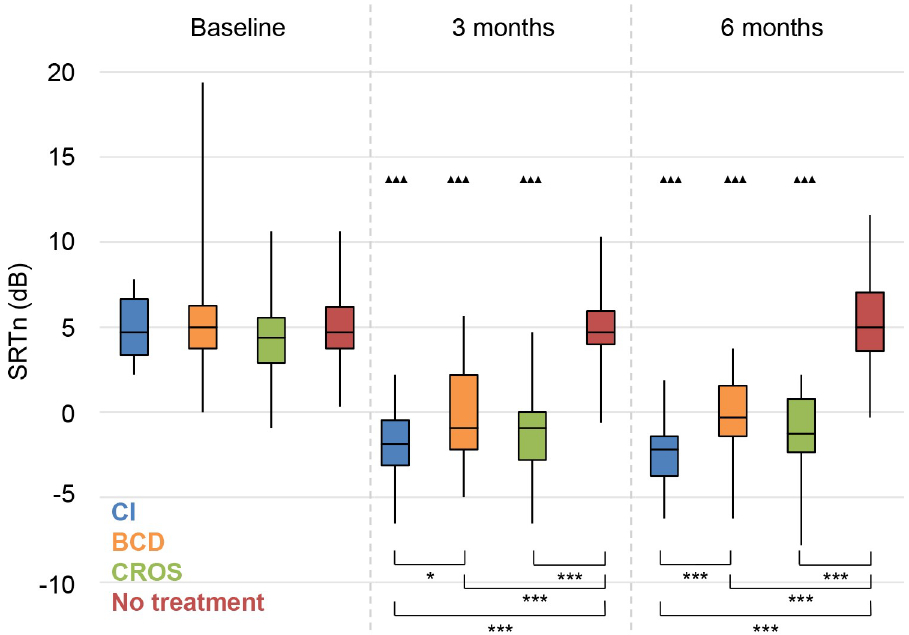
Fig 3. Speech perception in noise. Speech reception threshold in noise (SRTn) in decibels (dB), configuration S pe N be , Statistical difference compared to baseline. ▲▲▲ = p < 0.001; ▲▲ = p < 0.01; ▲ = p < 0.05. Statistical difference compared to 3 months follow-up. ■■■ = p < 0.001; ■■ = p < 0.01; ■ = p < 0.05. Statistical difference between groups at same follow-up moment. ��� = p < 0.001; �� = p < 0.01; � = p < 0.05.